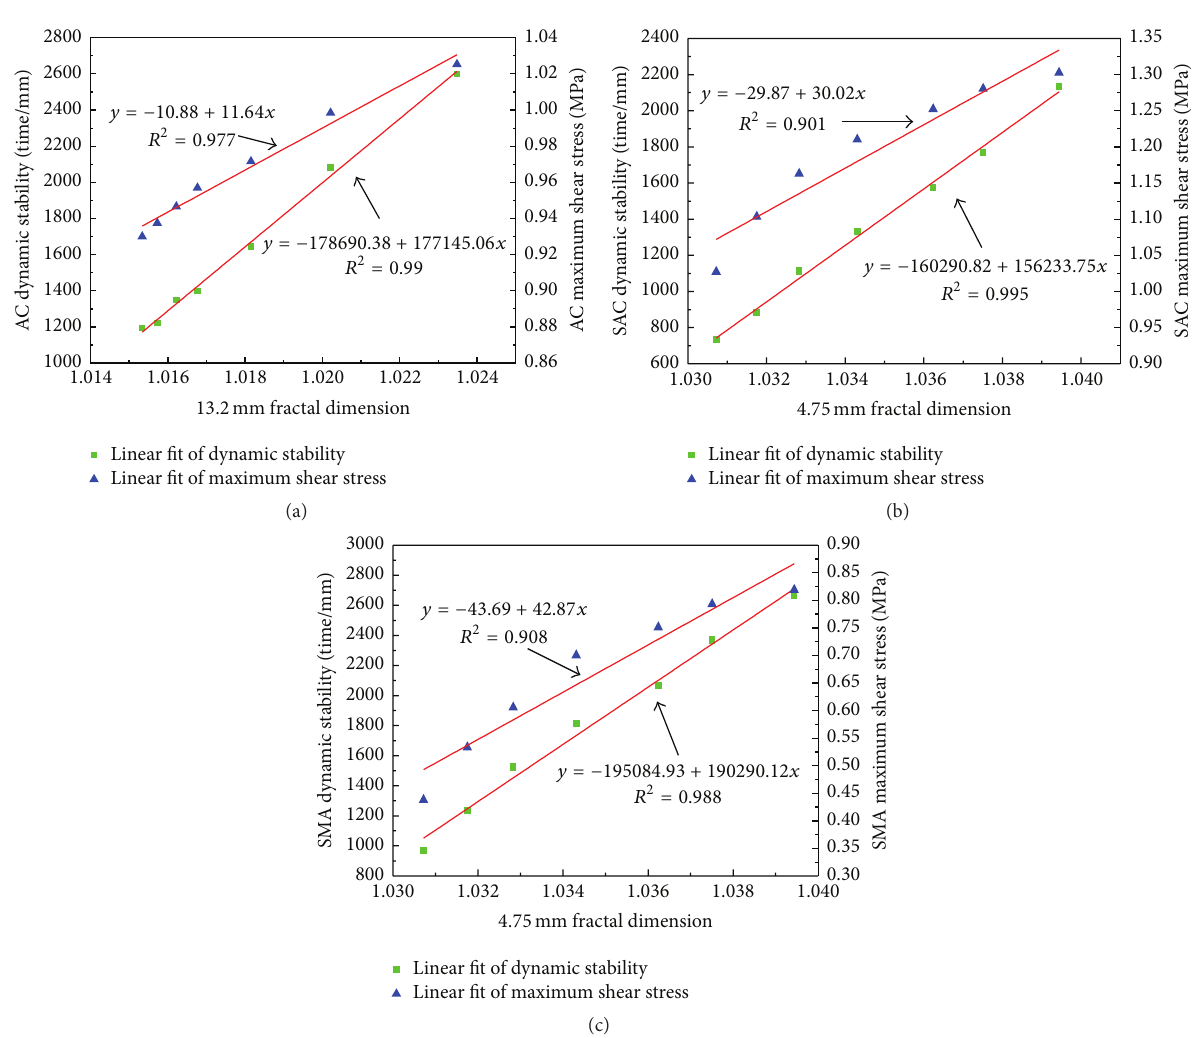
Figure 10: Regression analysis results: (a) AC-16, (b) SAC-16, and (c)